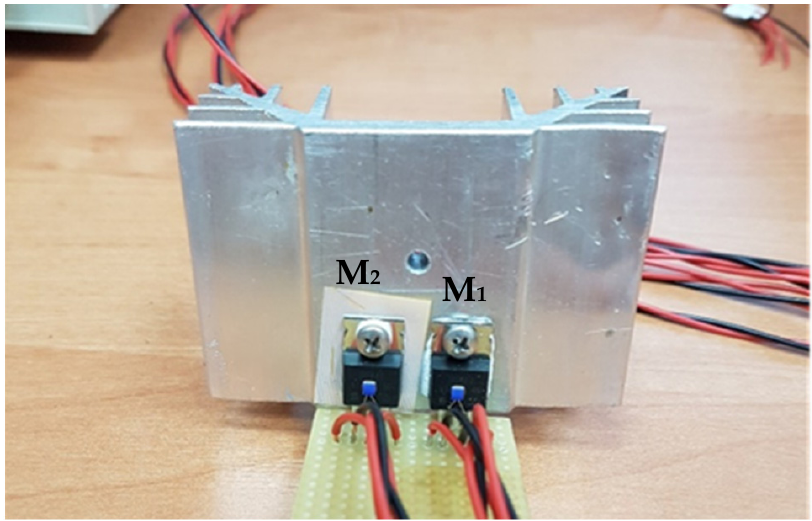
Figure 1. Tested transistors situated on the common heat-sink.